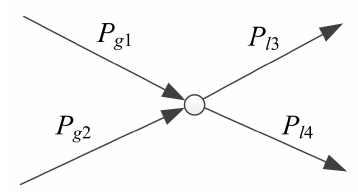
Figure 2. Power flow at a